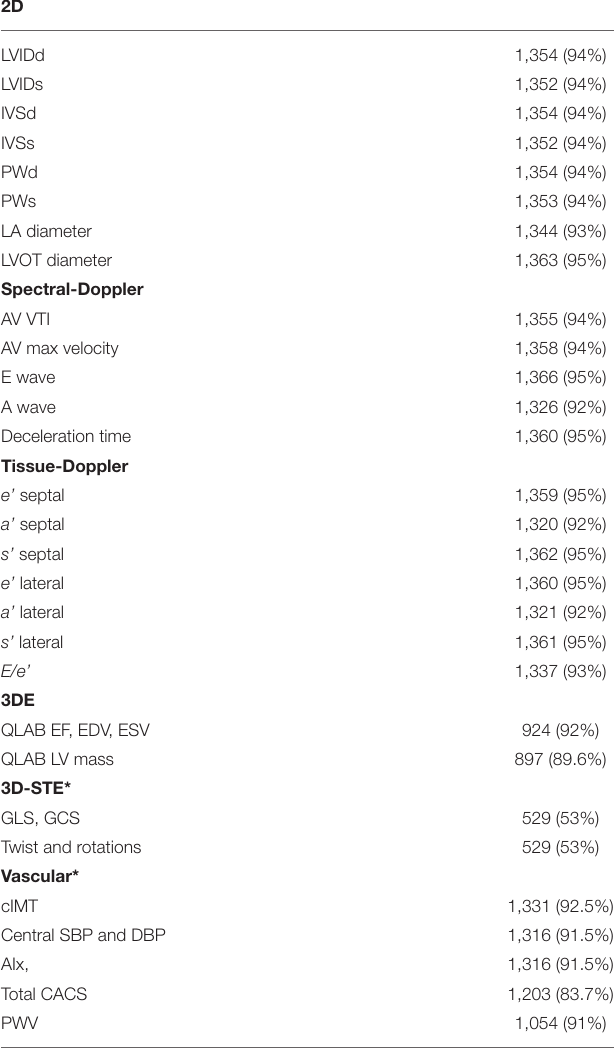
TABLE 4 | Feasibility of the cardiovascular measures in 1,438 SABRE